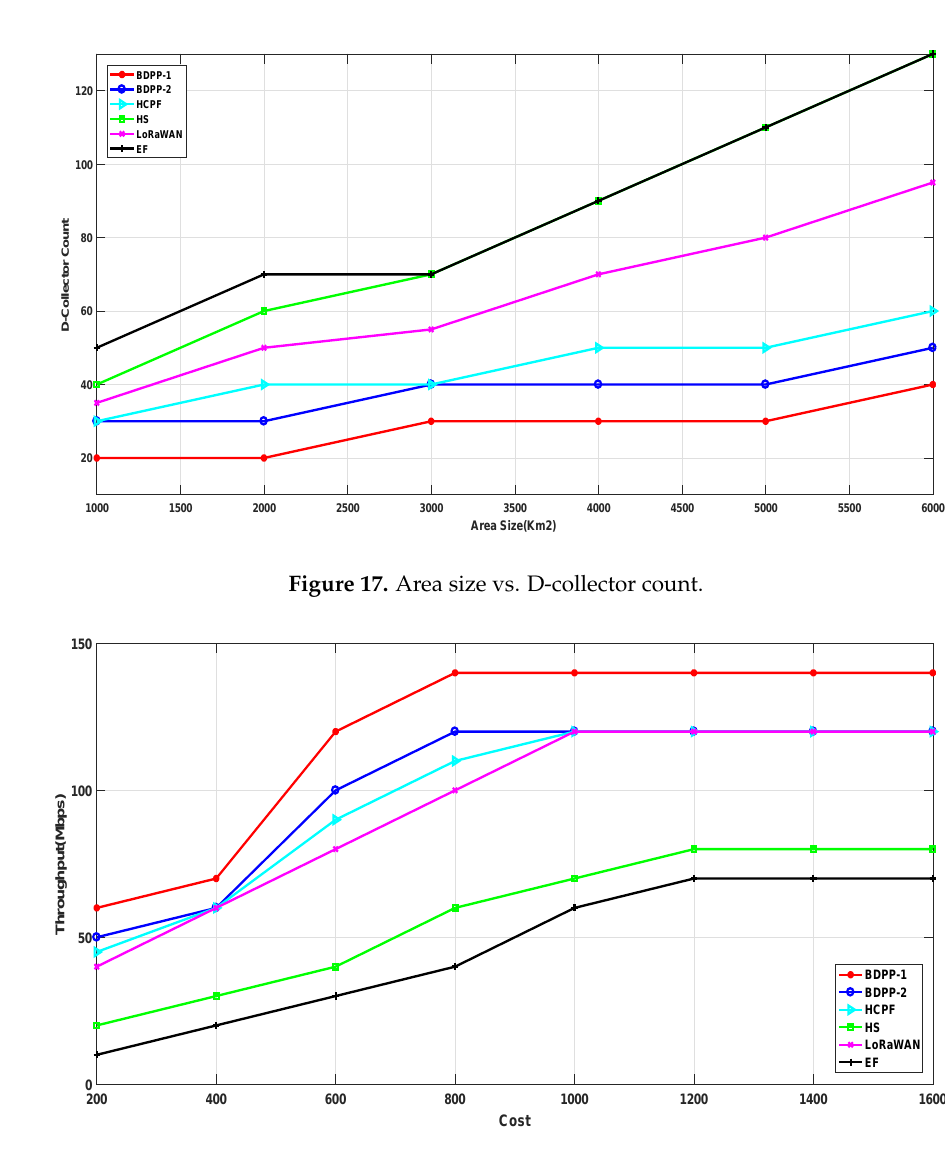
Figure 18. Total cost vs.